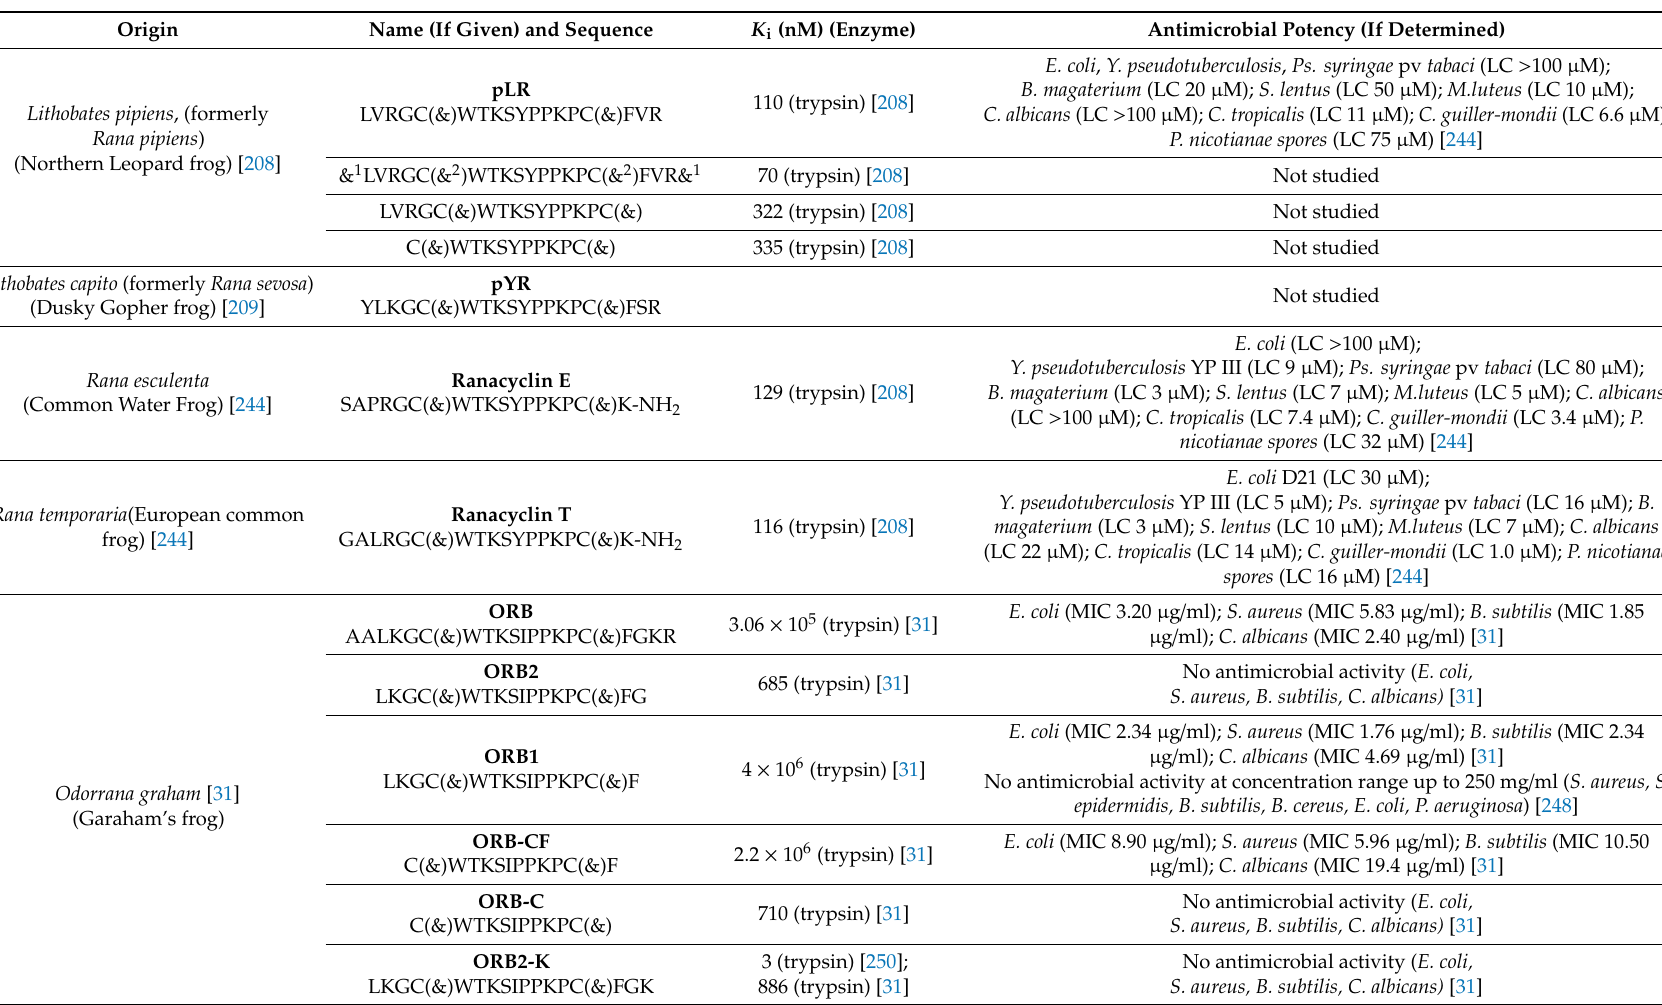
Table 4. Inhibitory activities expressed as K i values and antimicrobial properties expressed as MIC or lethal concentration (LC) values of amphibian-derived BBLTIs and their most important analogs. Modified positions are marked in